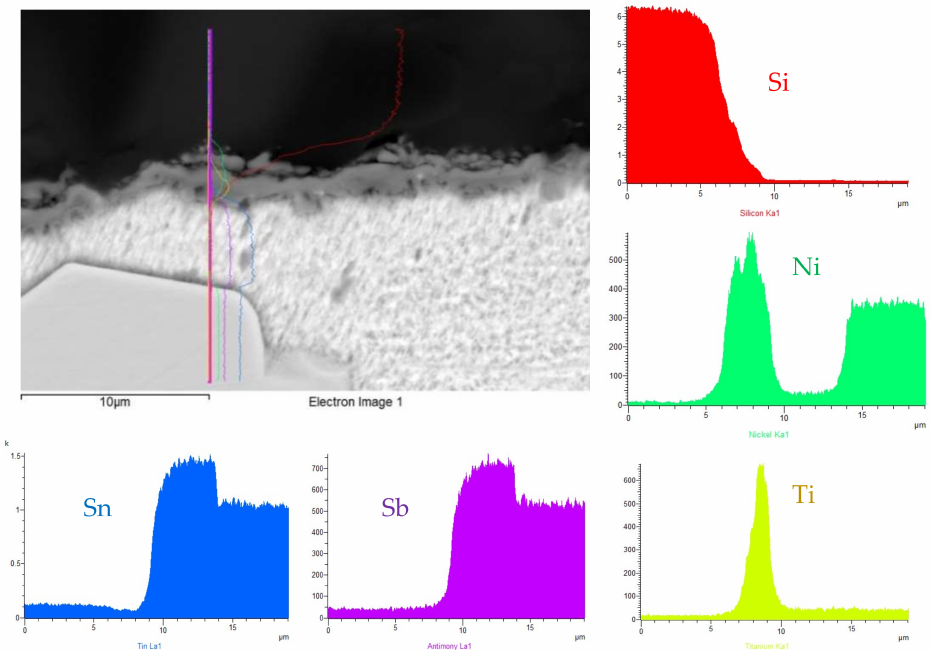
Figure 15. Line EDX analysis of SiC/Sn5Sb3Ti joint transition zone with a marked line and concen- tration profiles of Si, Ti, Ni, Sn and Sb